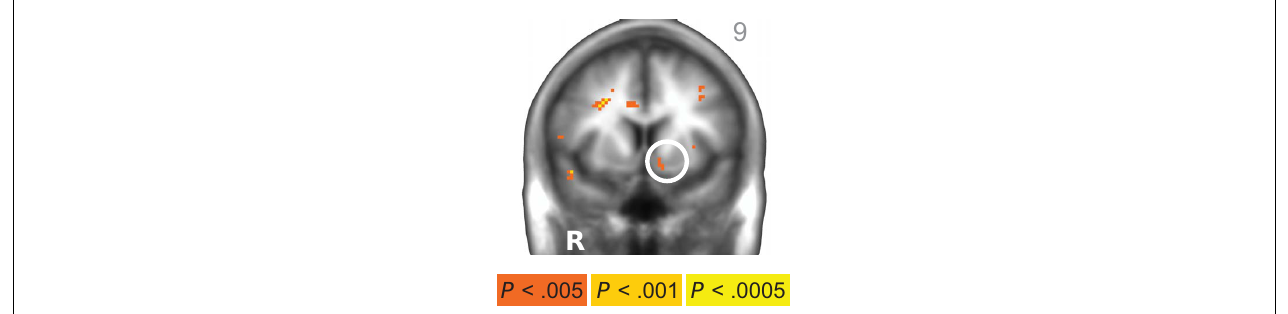
FIGUREA1 |Across subjects, a small cluster of β -system-related neural activity emerged in the left nucleus accumbens ( − 9, 9, − 8; peak Z = 3.066, 6 voxels) at p < 0.005, uncorrected. R = right. A/P value listed in upper right corner. Anatomical underlay is an average of all subjects’ spatially normalized structural scans.